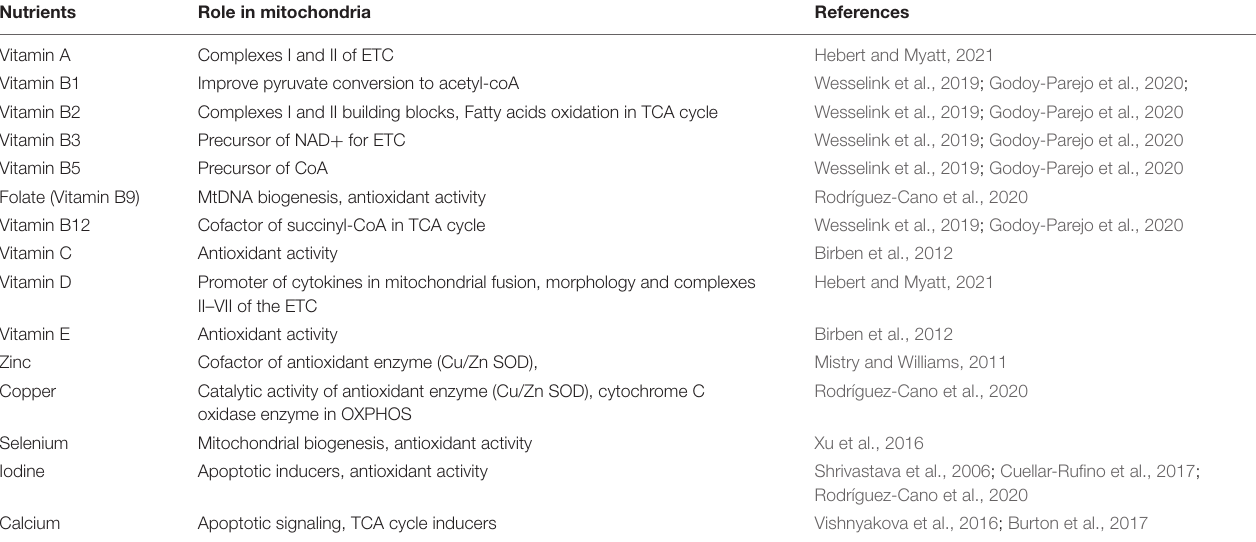
TABLE 2 | Role of nutrients in